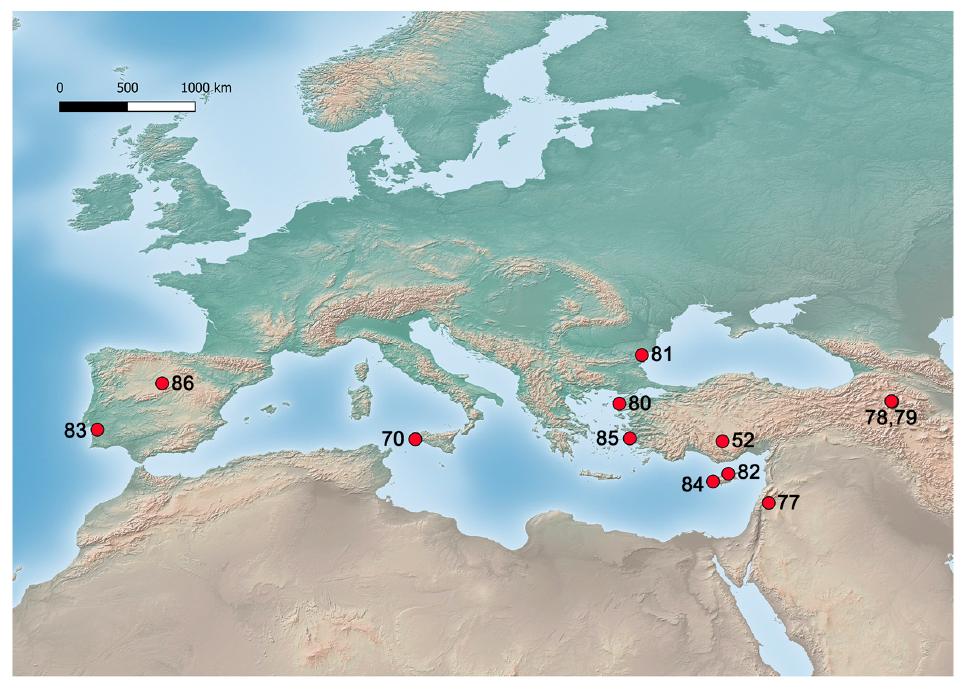
Figure 8. Middle Holocene sites where Celtis remains were reported (numbers in the figure correspond to ID numbers in Table 5) (map generated using QGIS version 3.4.13; Source: Natural Earth Data).